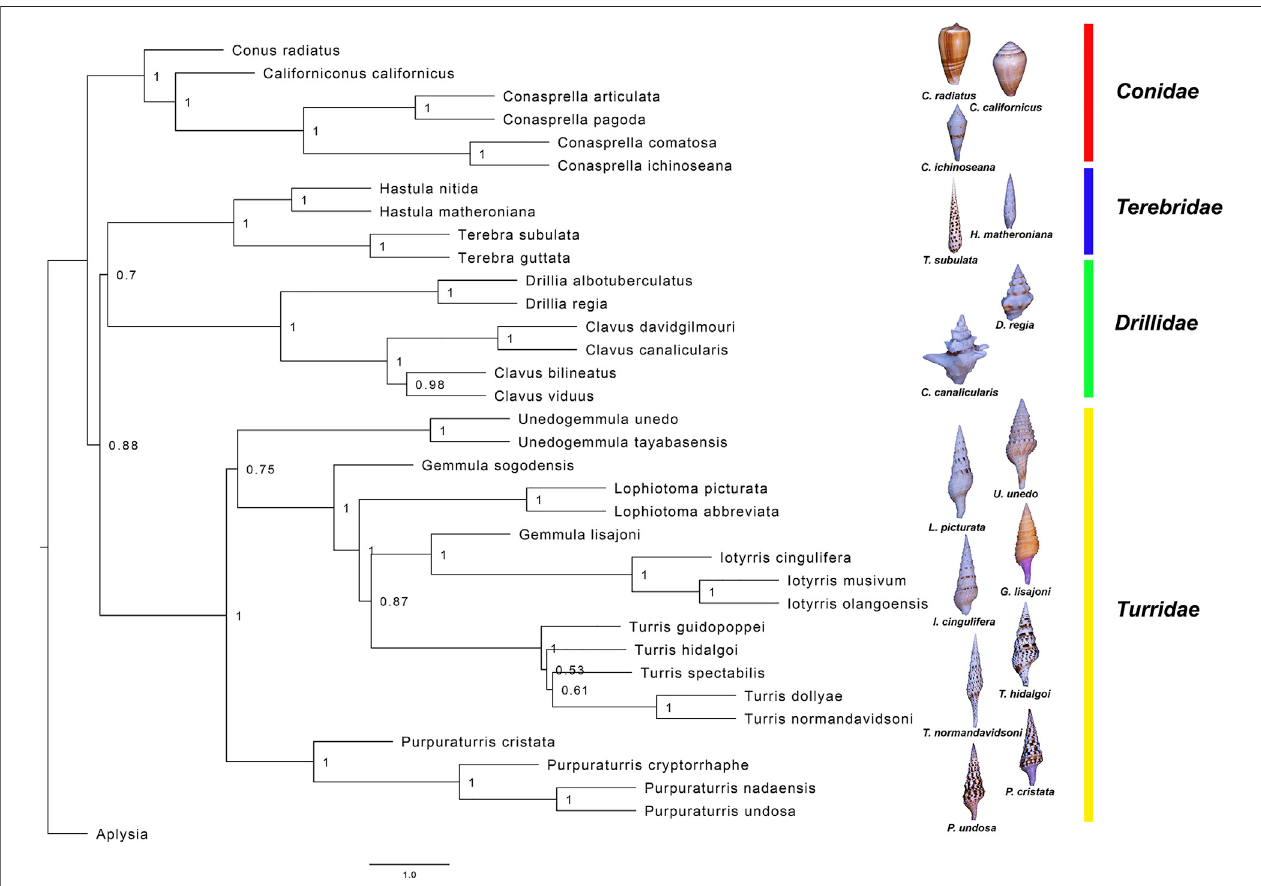
FIGURE 3 | Maximum likelihood phylogenetic tree based on transcriptome sequences from 66 contigs with blast identity to common housekeeping genes. The tree shown here represents the consensus tree from the 66 individual gene trees. The values at the nodes indicate the fraction of individual gene trees that support that node. The lengths of the terminal branches are undetermined. Conoidean families are labelled and representative images shown.